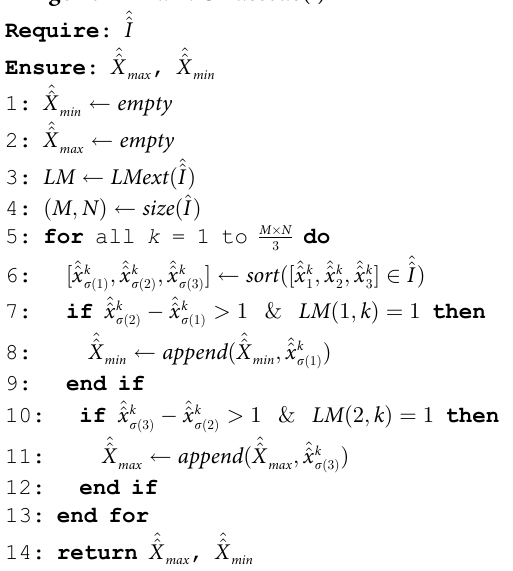
Algorithm 2 dPVO � decode ( �